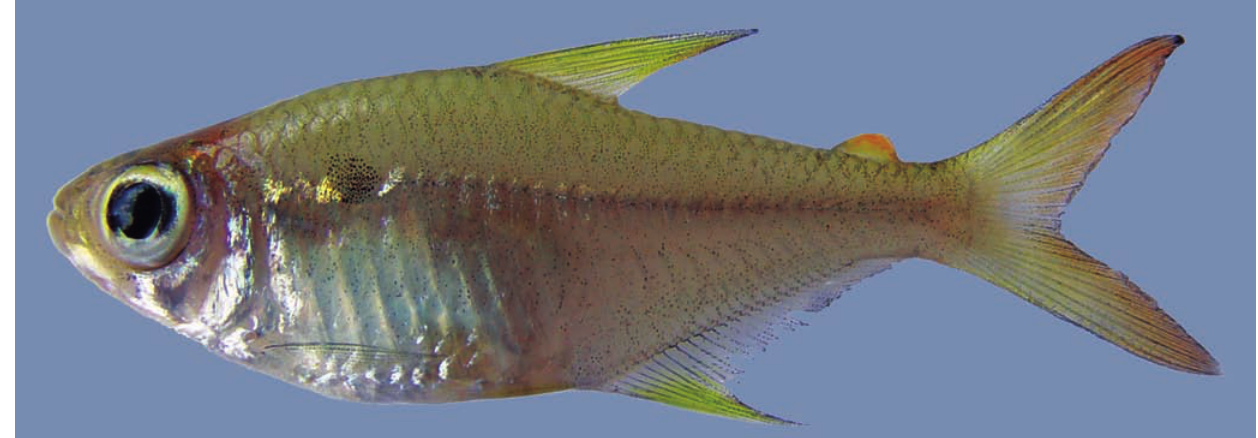
Fig. 5. Hemigrammus lunatus , NUP 2112, 35.9 mm SL, Brazil, Mato Grosso State, Rosário Oeste, córrego Imbaúba, tributary of rio Cuiabá, rio Paraguai